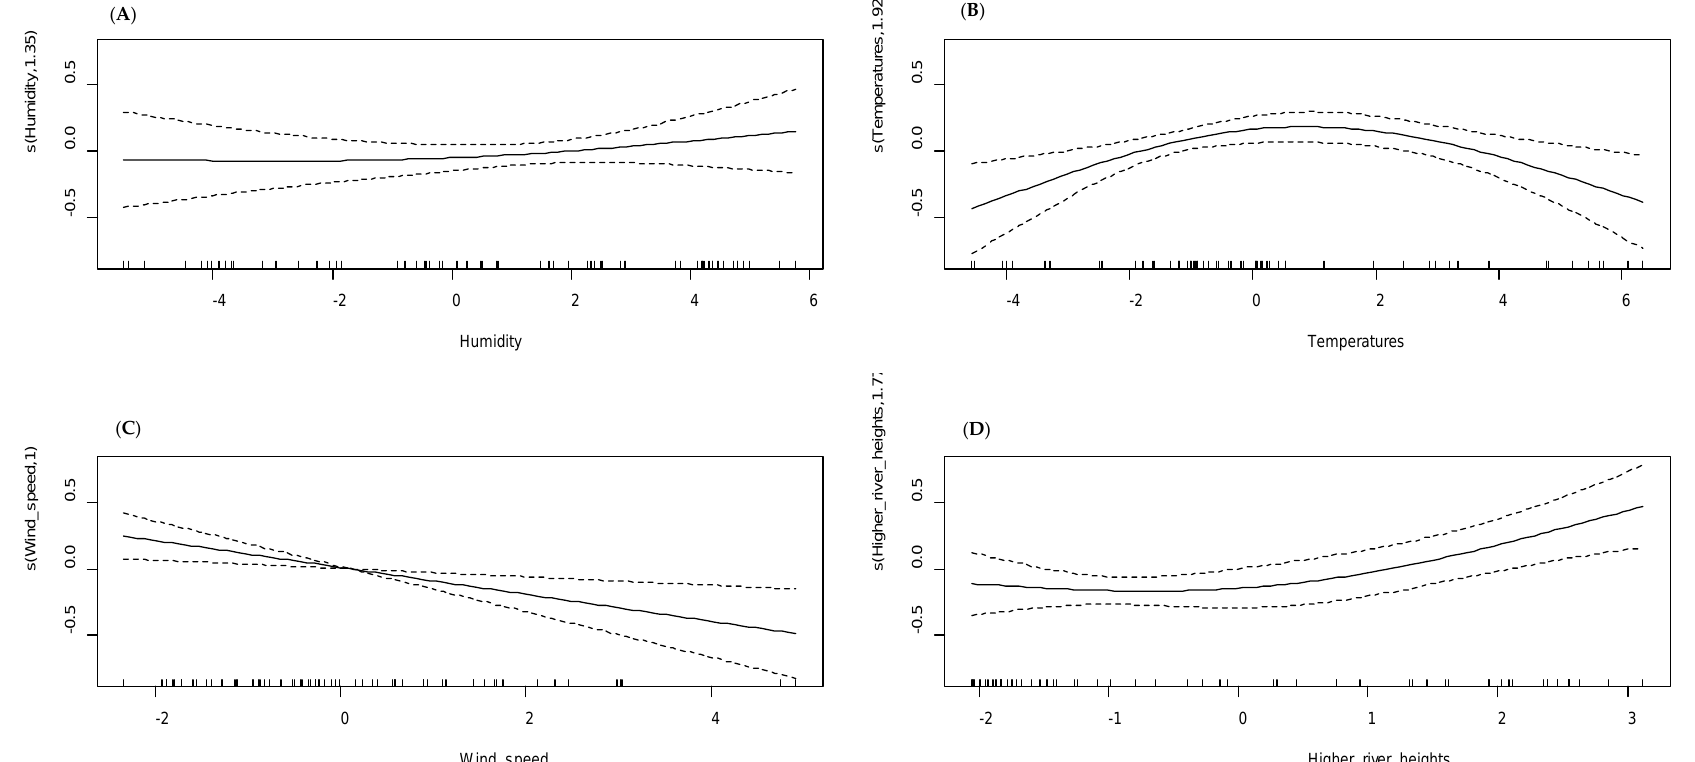
Figure 7. Relationship between climatic, meteorological and hydrological components (multivariate GAM model), Koila. ( A ) Rainfall, temperature, humidity, vegetation, wind speed (Kmt1); ( B ) vegetation, high temperatures (Kmt2); ( C ) all the meteorological components variations (Kmt3); ( D ) high temperatures (Kmt4); humidity, vegetation, wind speed, temperature (Kmt5); river heights (Khriv1).